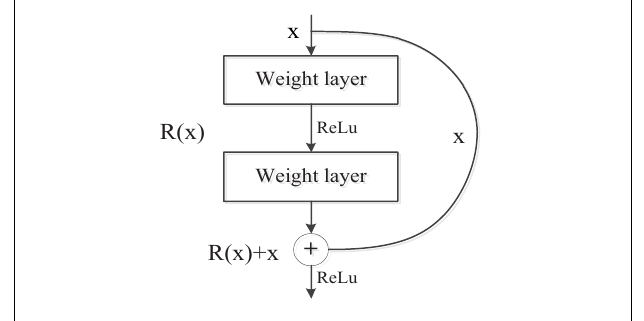
FIGURE 3 | Residual learning process.